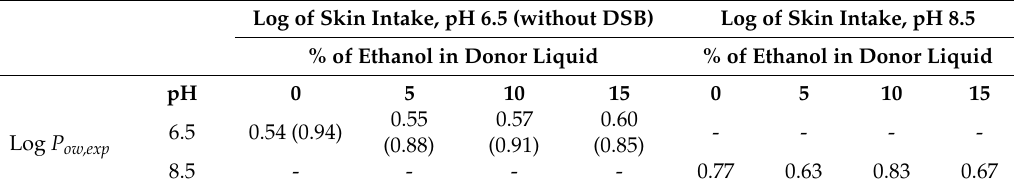
Table A6. Correlation coefficients (r 2 ) between experimental n -octanol/water partition coefficients (log P ow,exp ) and skin intake at pH 6.5 and 8.5.